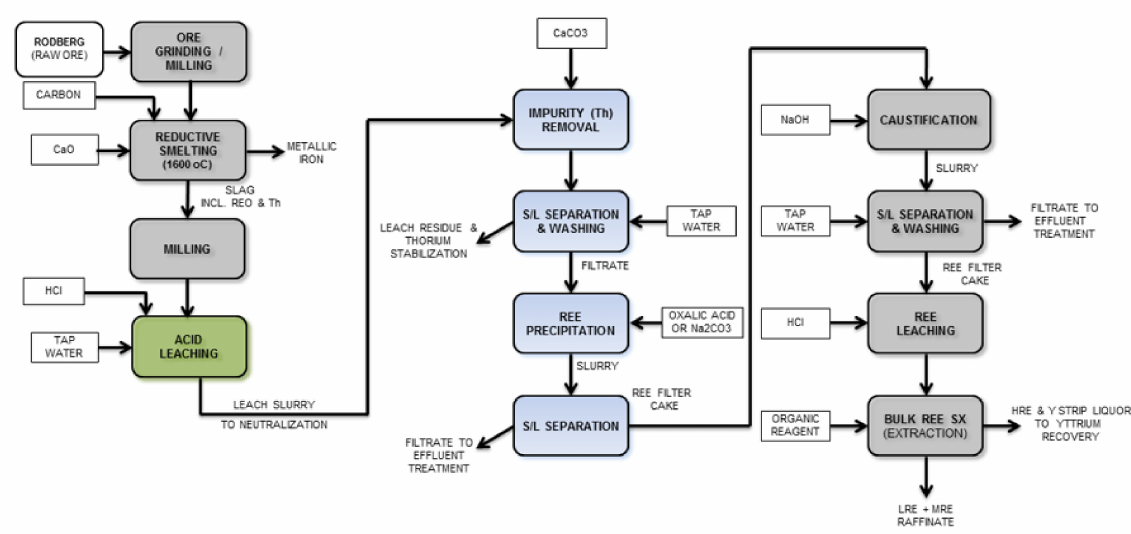
Figure 9. Treatment of bastnasite concentrate by MEAB Chemie Technik GmbH and IME, RWTH